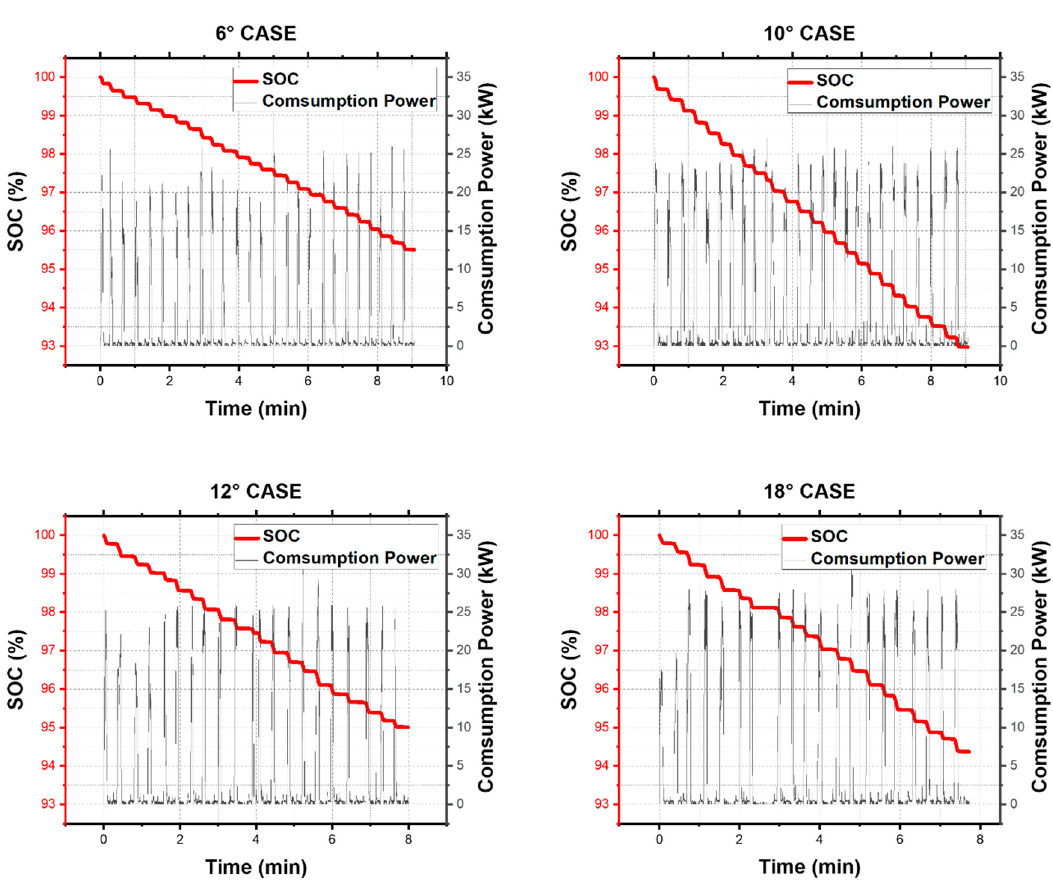
Figure 10. Power consumption trend based on uphill driving angle.